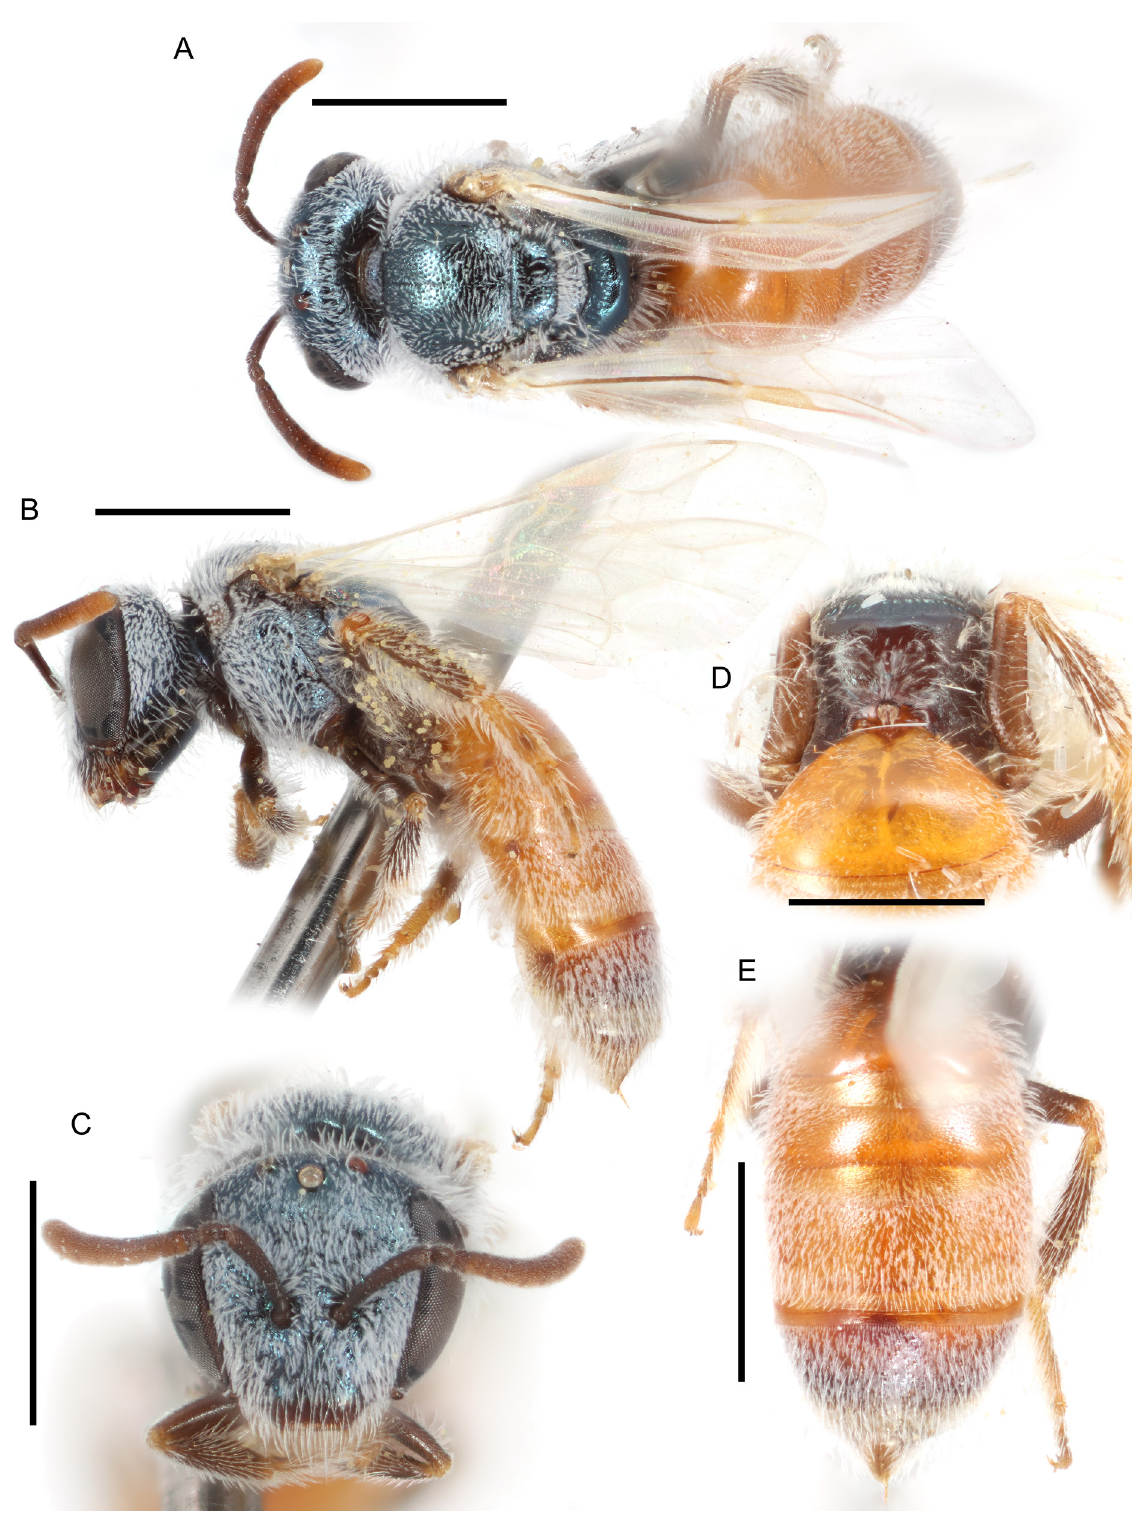
Fig. 67. Lasioglossum ( D. ) pallidellum (Ellis, 1914), red morph, ♀. A . Dorsal habitus. B . Lateral habitus. C . Face. D . Propodeum. E . Metasoma. Scale bars: 1